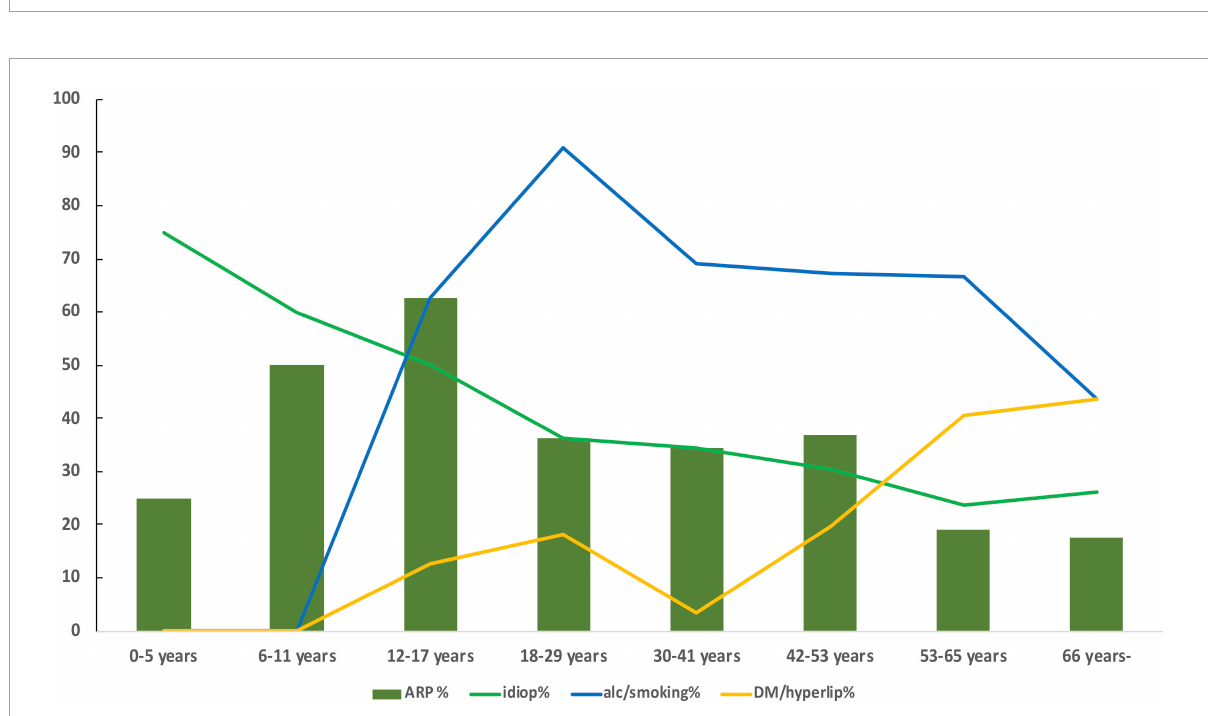
FIGURE2 Pancreatitis recurrence rate (ARP%, dark green columns), idiopathic etiology rate (idiop%, light green line), alcohol and/or smoking prevalence (alc/smoking%, blue line), and diabetes and/or hyperlipidemia prevalence (DM/hyperlip%, yellow line) at the time of the index enrolment in the AP registry in the positive pancreatic family history